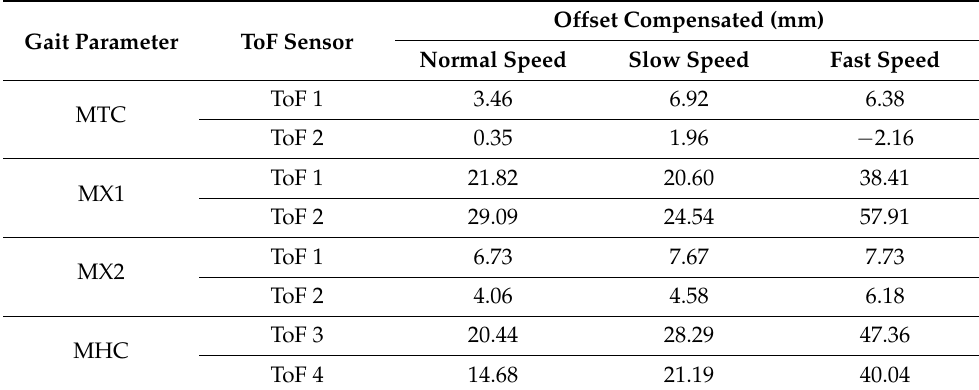
Table 2. A summary of the offset means for each gait parameter, ToF sensor, and walking speed. Offset Compensated (mm) Gait Parameter ToF Sensor Normal Speed Slow Speed